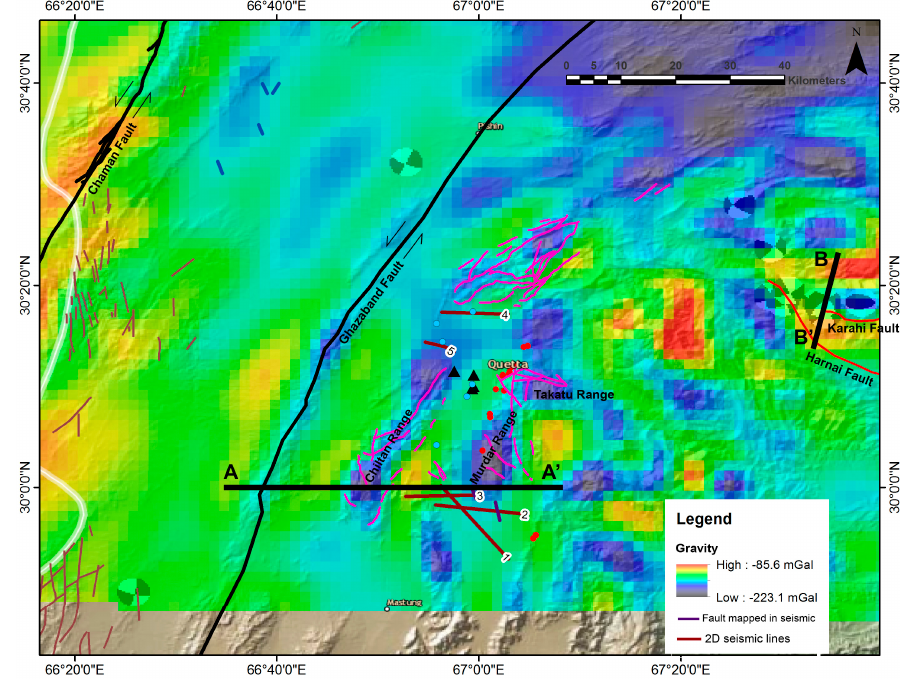
Figure 4. Bouguer gravity anomaly ranging from − 85.6 to − 223.1 mGal shows the crustal